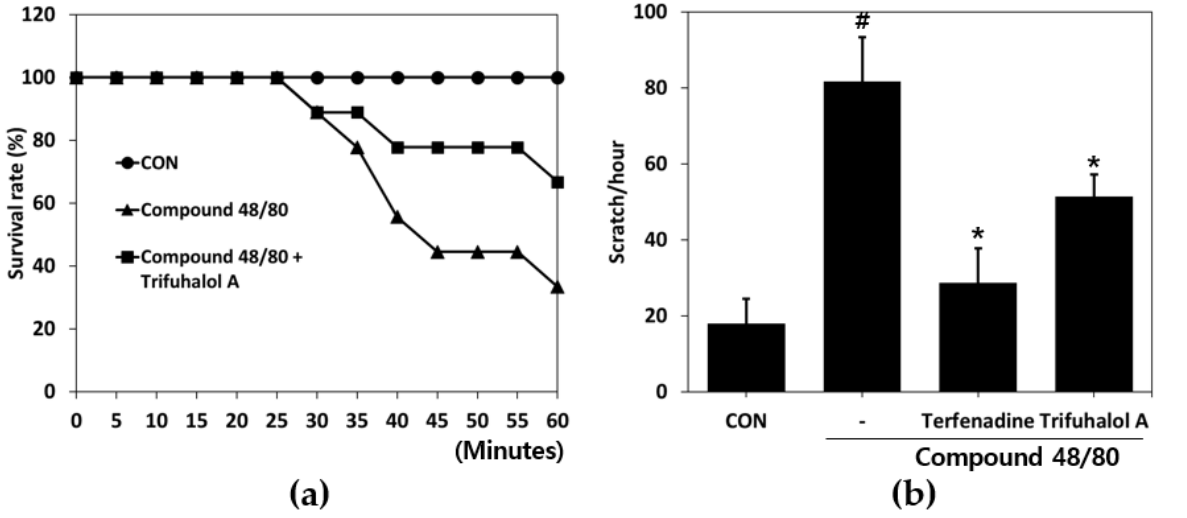
Figure 3. Effects of trifuhalol A on Compound 48/80-induced anaphylactic shock and scratching behavior in ICR mice. ( a ) Mice were administered trifuhalol A (200 mg/kg) for 1 h before Compound 48/80 injection (10 mg/kg i.p.) (n = 9 per group). The survival rates of these mice were monitored for 1 h. ( b ) Mice were treated with or without trifuhalol A (20 mg/kg) or terfenadine (4 mg/kg) for 1 h before Compound 48/80 injection (50 µ g/kg s.c.) (n = 3 per group). The scratching behavior was counted for 1 h after Compound 48/80 injection. Each bar represents the mean ± S.D. # p < 0.05 vs. control group; * p < 0.05 vs. Compound 48/80-treated group.